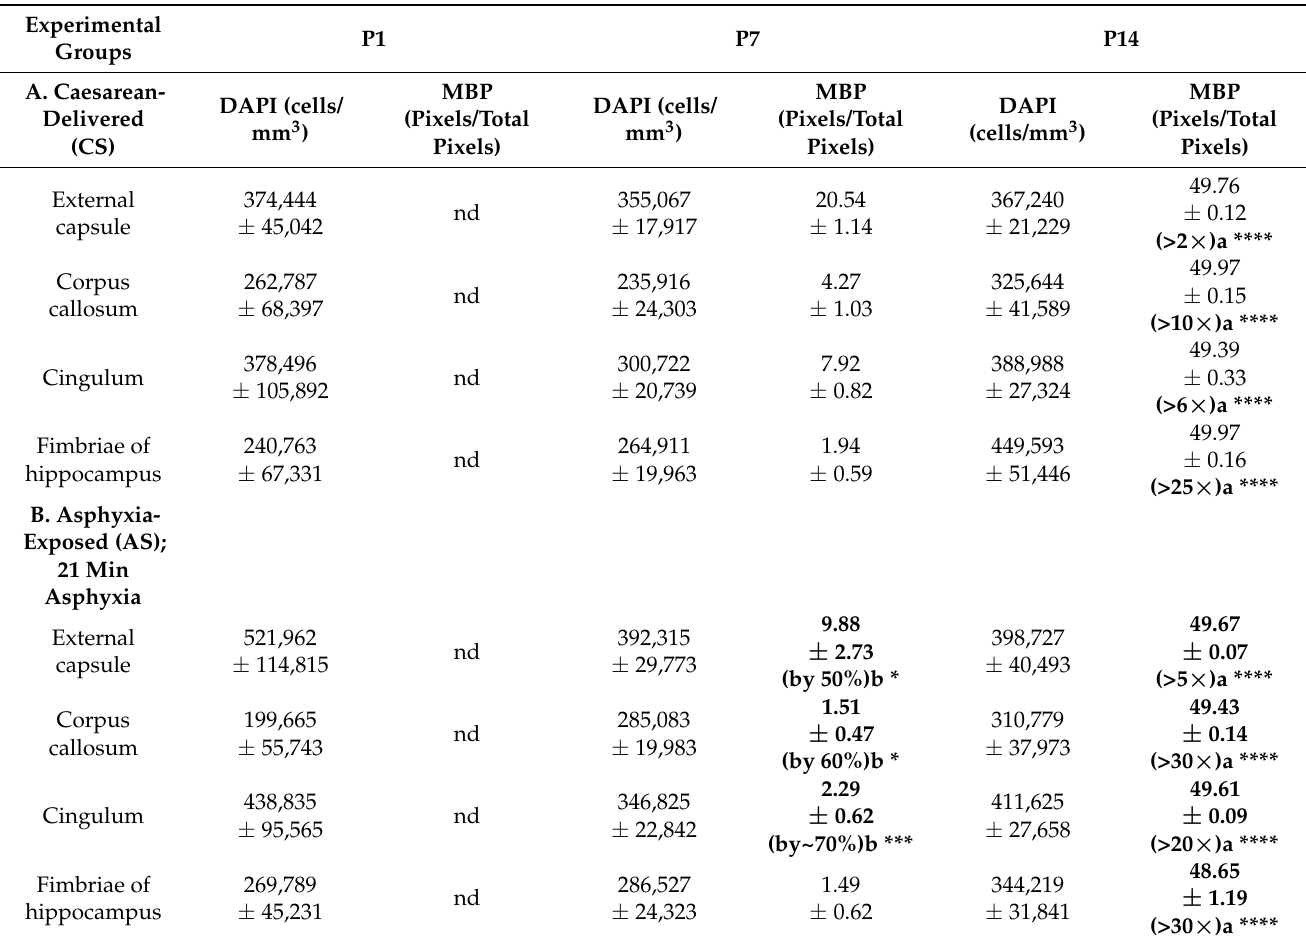
Table 2. Effect of neonatal development and perinatal asphyxia (PA) on myelination (MBP; pixels/total pixels) in telencephalon (external capsule, corpus callosum, cingulum) and fimbriae of hippocampus) at P1, P7, and P14. Coronal sections of telencephalon and hippocampus were treated for immunohistochemistry against MBP, counterstained with DAPI. Microphotographs (two-five samples per brain region) were taken from external capsule, corpus callosum, cingulum, and fimbriae of hippocampus, in the field of a confocal-inverted Olympus-fv10i microscope at 60 × . The mean percentage of MBP immunopositive pixels over the total pixel number was estimated using ImageJ software. Data are shown as means ± S.E.M from at least n = 5 independent experiments. Unbalanced two-way ANOVA indicated a significant effect of postnatal days (neonatal development) on MBP (pixels/total pixels) ( A ), increased in both CS (>2 × , external capsule; >10 × , corpus callosum; >6 × , cingulum, and >25 × in fimbriae of hippocampus) and AS (>5 × , external capsule; >30 × , corpus callosum; >20 × , cingulum, and >30 × in fimbriae of hippocampus) animals. At P7, MBP levels were decreased in external capsule, corpus callosum, and cingulum of AS versus CS animals ( B ) [external capsule (F(4, 25) = 230.066, p < 0.0001); corpus callosum (F(4, 25) = 3669.906, p < 0.0001); cingulum (F(4, 25) = 2037.145, p < 0.0001)], but not in fimbriae of hippocampus (F(4, 25) = 0.045, p = 0.833). Benjamini–Hochberg was used as a post hoc test. No statistically significant differences were observed